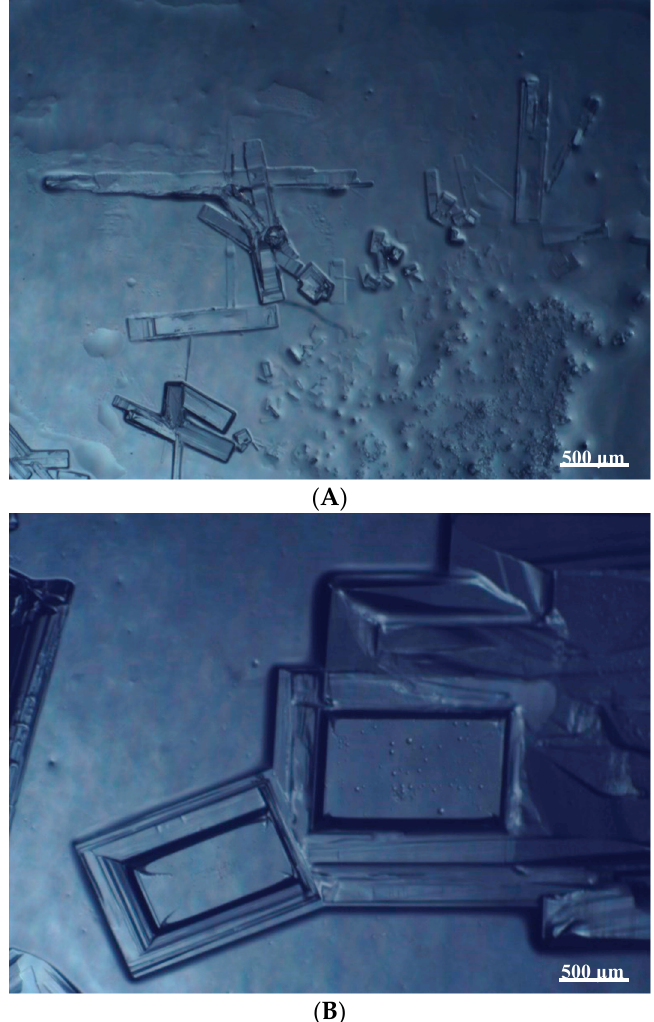
Figure 1. Optical microscopy image of the lidocaine: L -menthol ( A ); and lidocaine: DL -menthol ( B ) cocrystals.